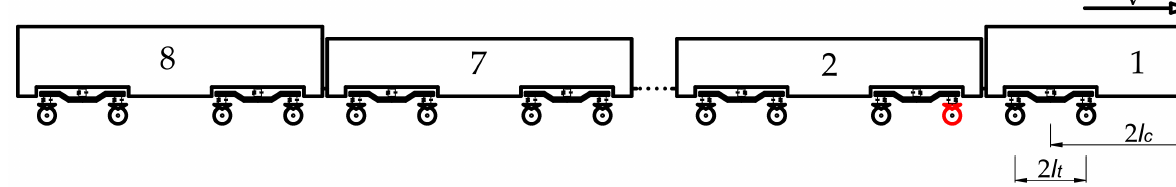
Figure 1. Illustration of the configuration of high-speed trains modeled in this